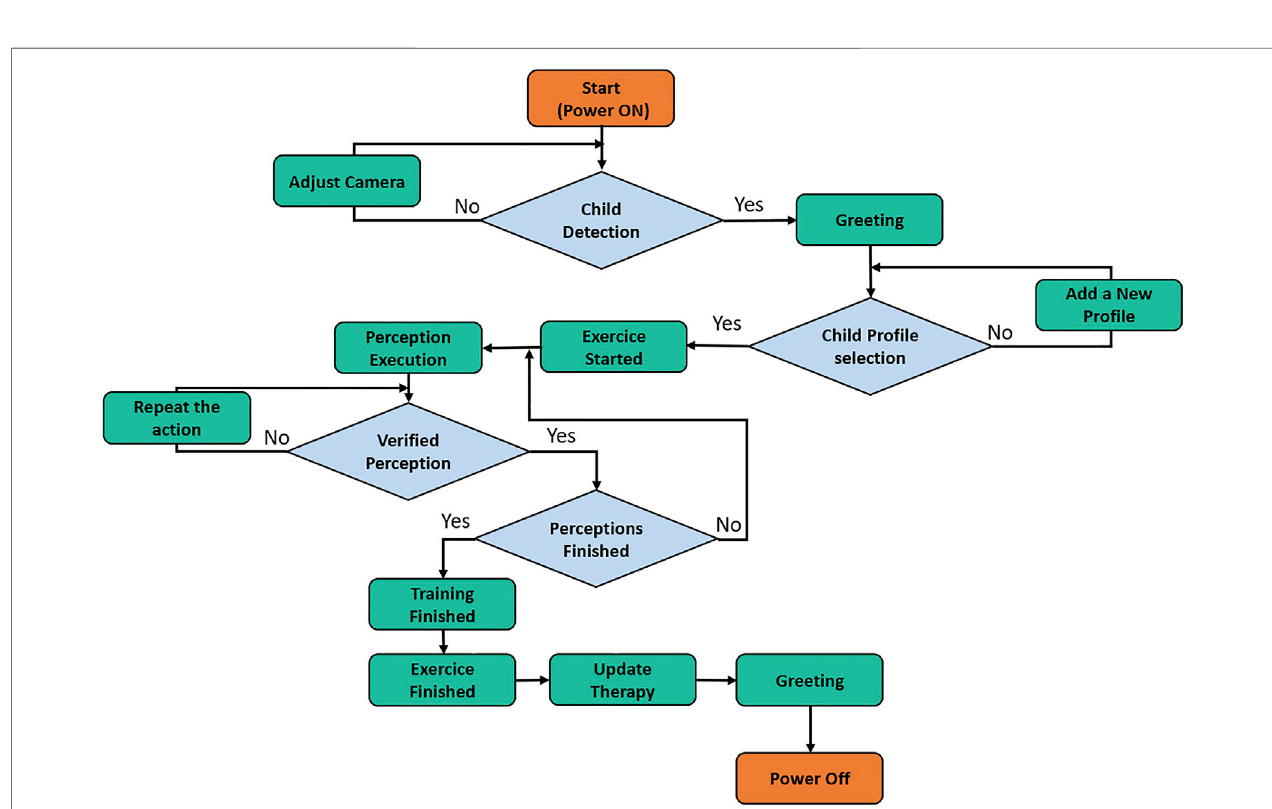
FIGURE 6 | The fl ow of therapy by the robot.